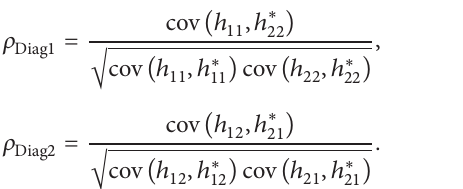
Figure 2: CDF of the magnitude of the correlation coefficients extracted from the measurements.